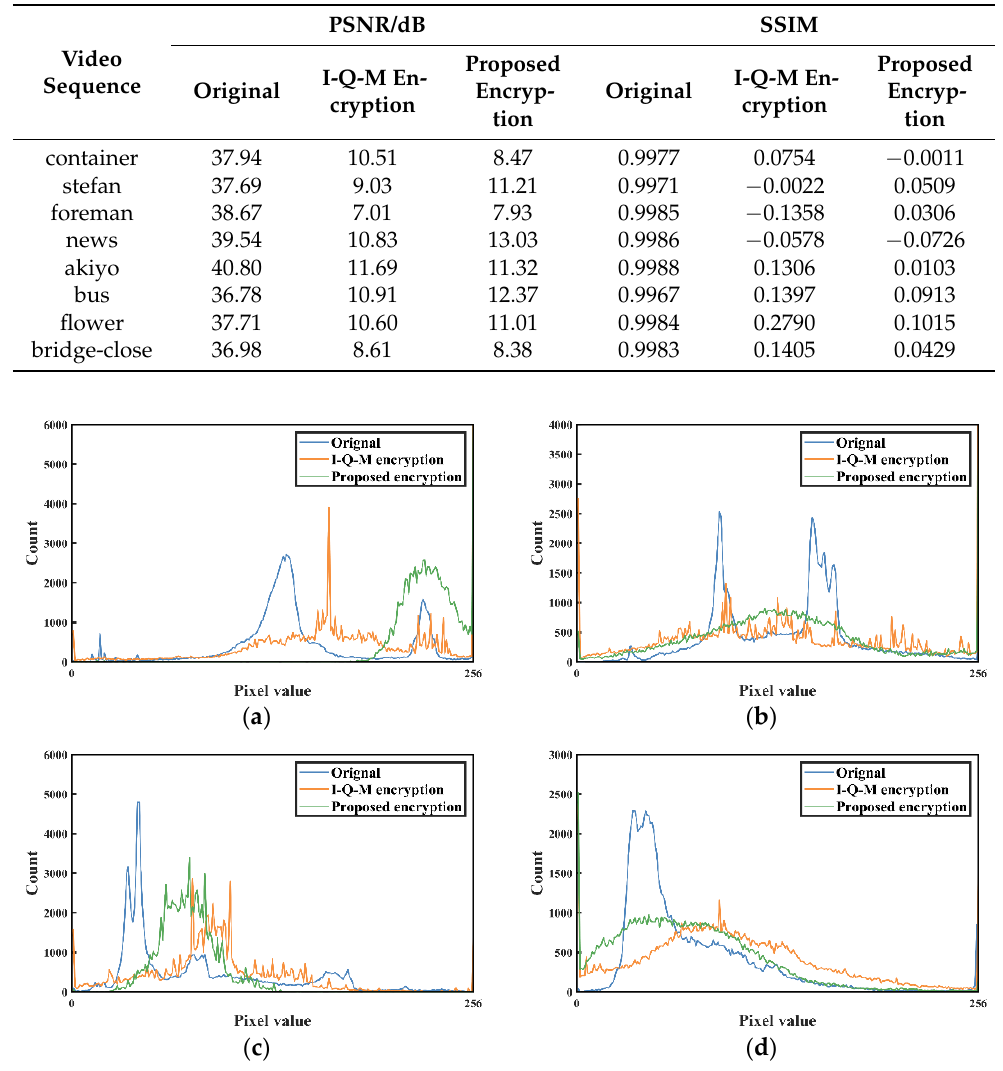
Table 2. Comparison between PSNR and SSIM after encryption.